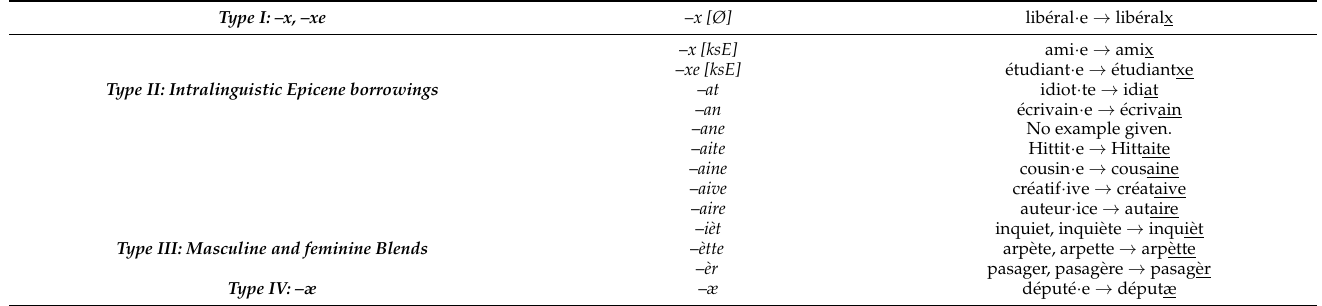
Table 5. Neutral Singular Nominal Allomorphs in Ashley (2019).